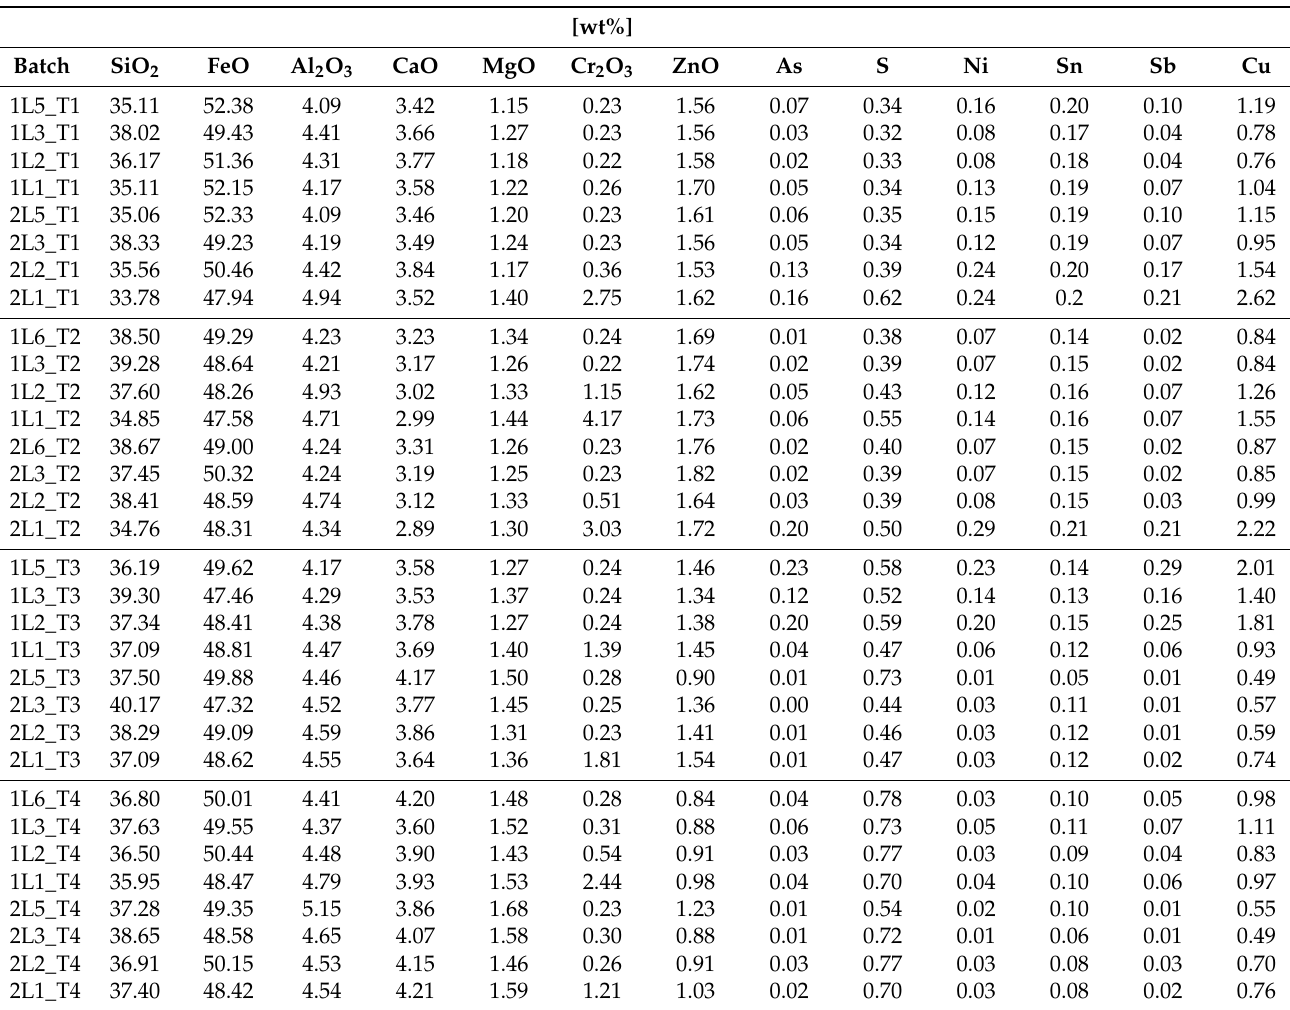
Table A2. Normalized chemical composition of vertical slag samples from batch T1–T4. [wt%] Batch SiO 2 FeO Al 2 O